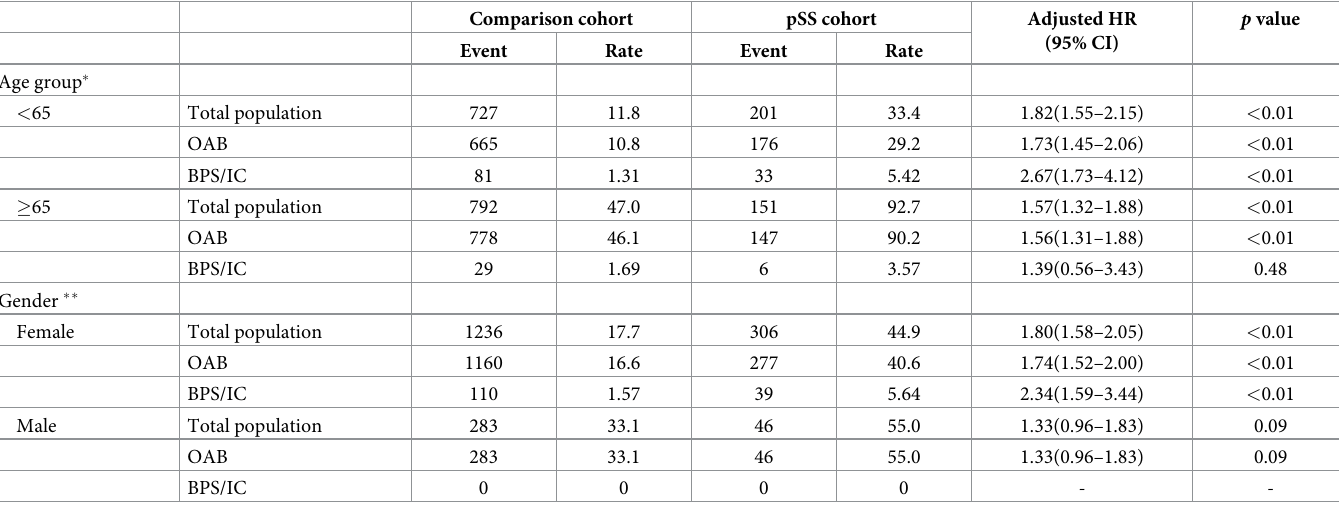
� Adjusted for gender and comorbidities (hypertension, coronary artery disease, type 2 diabetes mellitus, chronic pelvic pain, chronic fatigue syndrome,